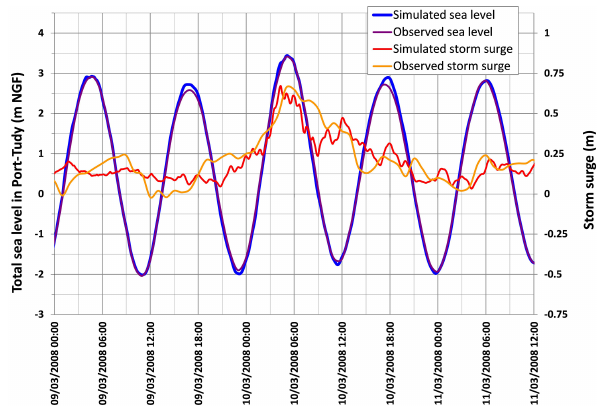
Figure 5. Validation of the wave characteristics simulated in the IOWAGA project on the Pierres-Noires gauge (observation from